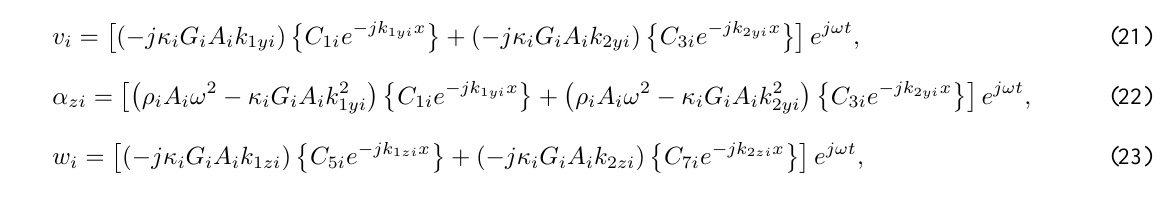
Fig. 4. The power transmission and reflection coefficients of two semi-infinite Timoshenko beams with the same material and geometrical properties joined at 45 ◦ : (a) Case of the incident BDFW with wavenumber k 1 , (b) Case of the incident SDFW with wavenumber k 2 , (c) Case of the incident longitudinal